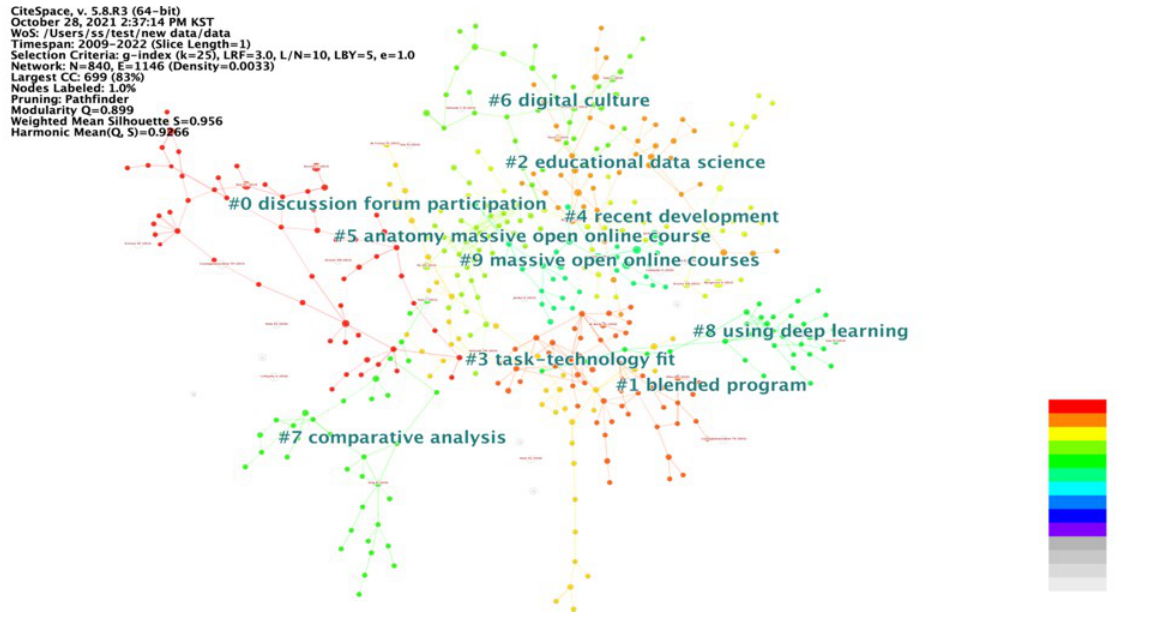
Top Nine Clusters Based on Co-Citation Network (2009 –